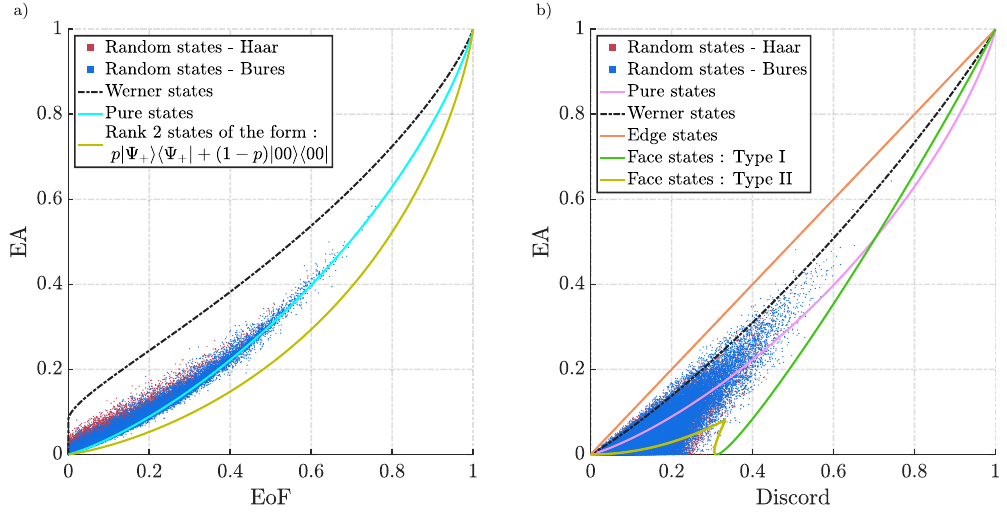
5 randomly generated